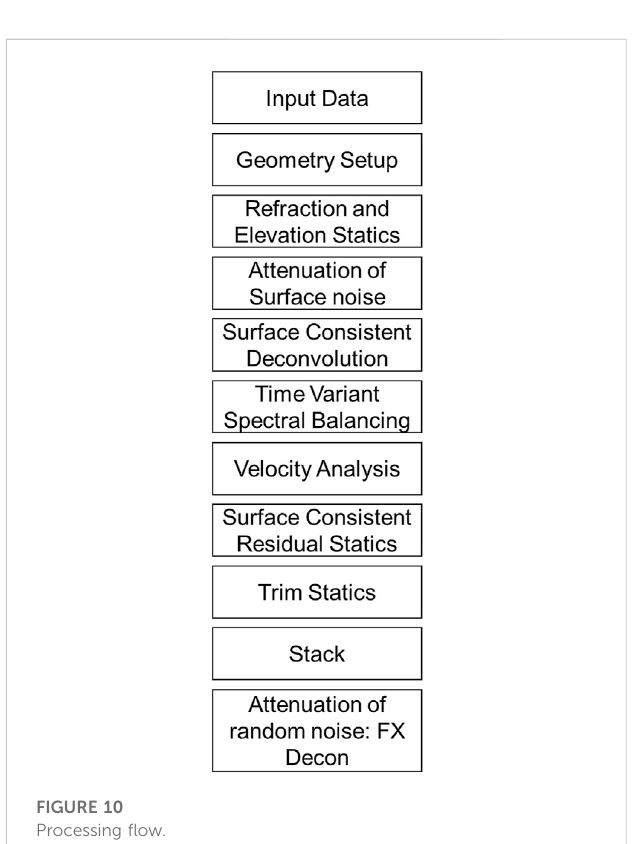
FIGURE 10 Processing fl